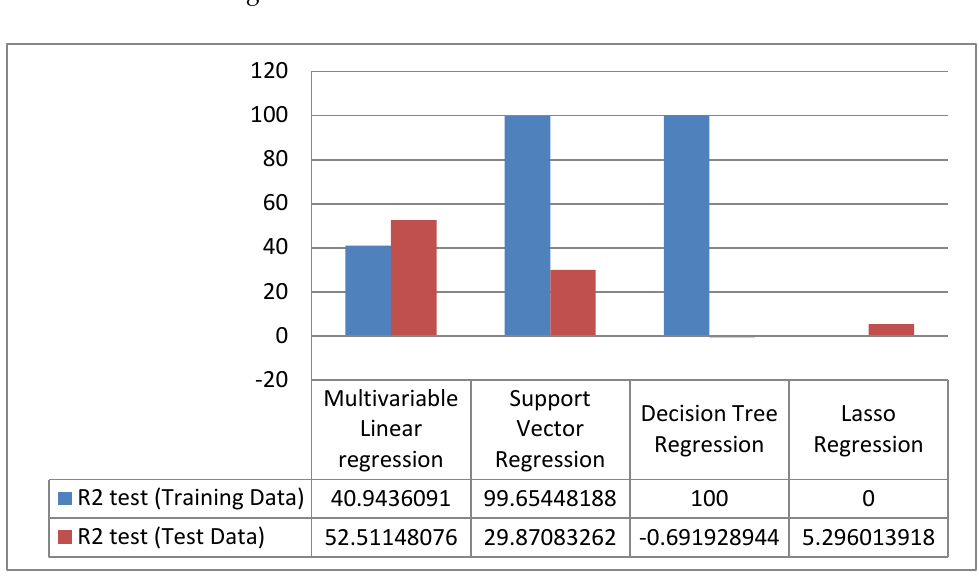
Figure 4. R 2 result for Temperature.